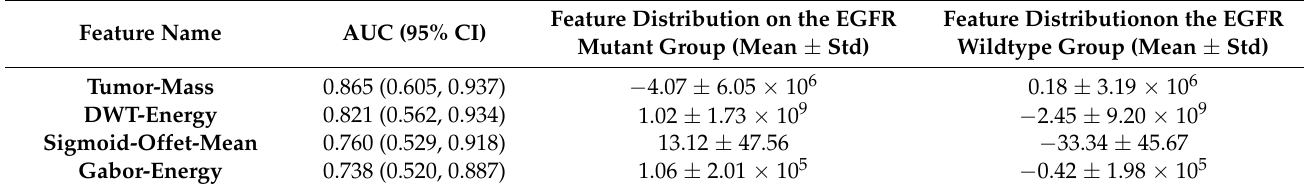
Table 2. Identified non-redundant and informative radiomics features.